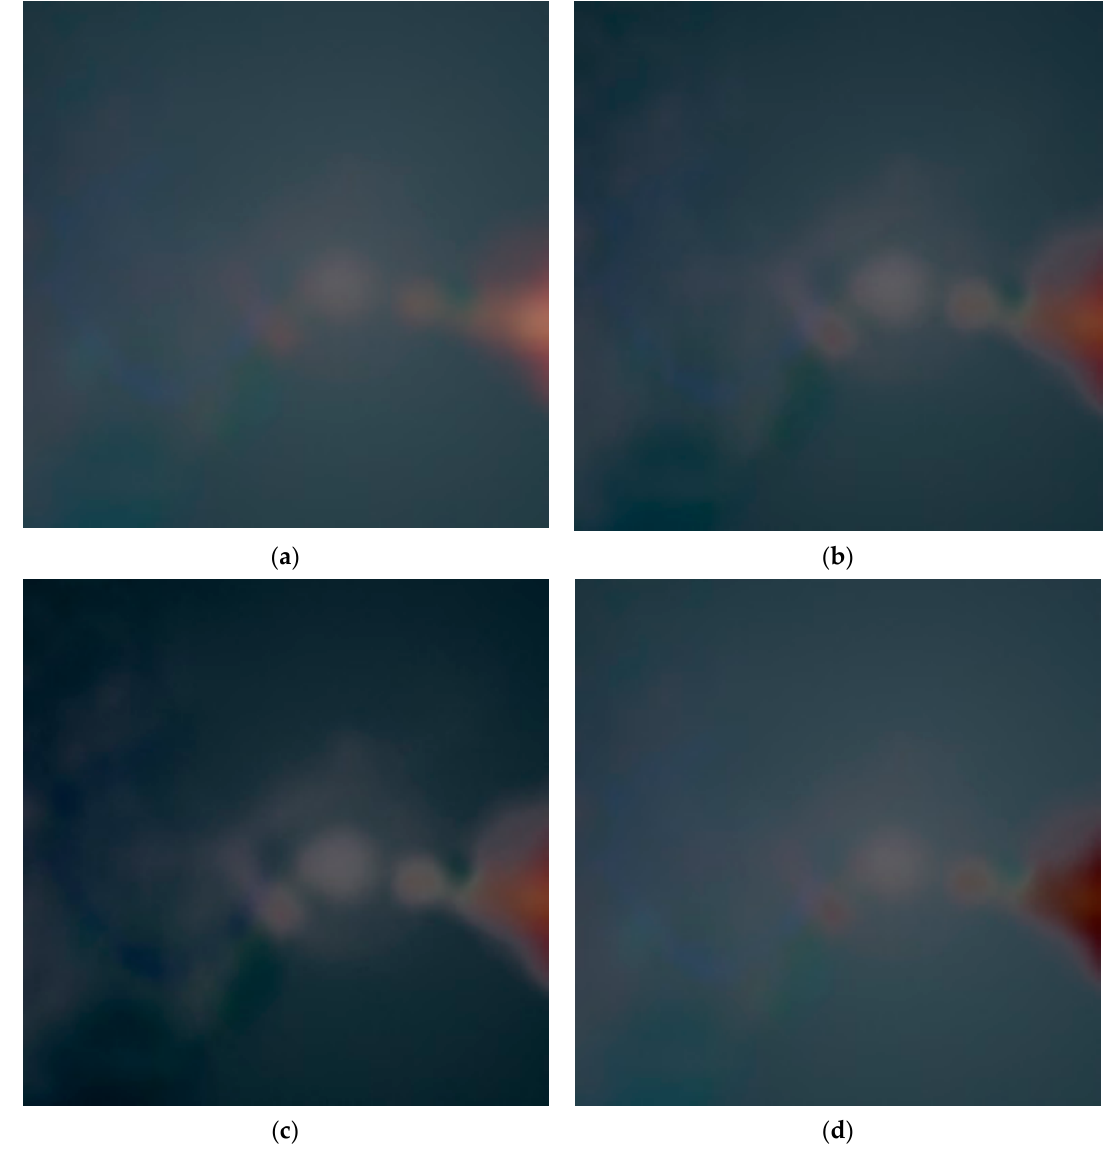
Figure 8. Magnification of M87 ′ s galactic core structure: ( a ) original image of M87 in Figure 5a, ( b ) 22 nd ISED-generated image in Figure 5b, ( c ) 23 rd ISED-generated image in Figure 5c, and ( d ) 24 th ISED-generated image in Figure 5d.